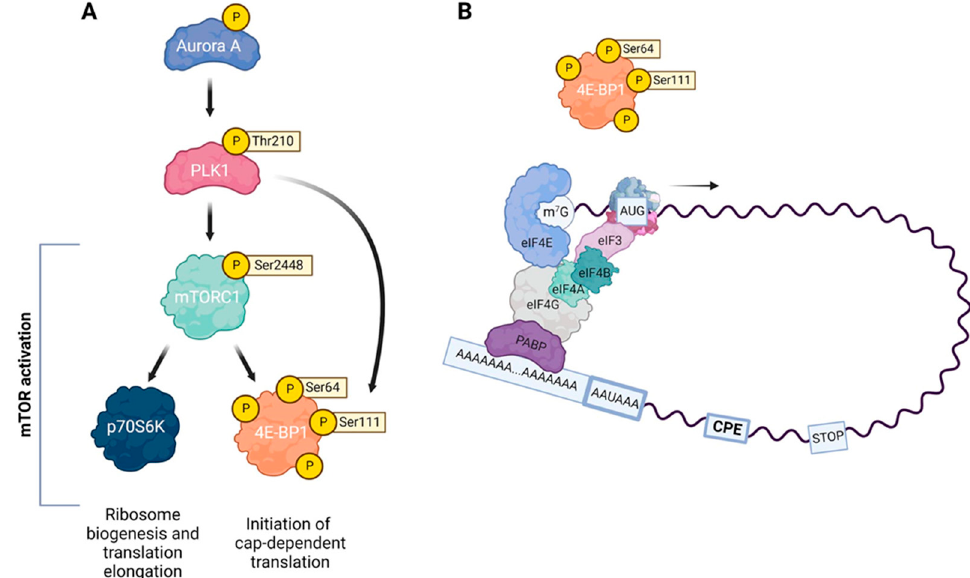
Figure 3. Role of PLK1 in the initiation of translation. ( A ) Activation of polo-like kinase 1 (PLK1) requires phosphorylation of conserved threonine residue (Thr 210) by aurora kinase A (AURKA). Later PLK1 phosphorylates the mammalian target of rapamycin complex 1 (mTORC1), which plays a major role in the phosphorylation and inactivation of eukaryotic translation initiation factor 4E (eIF4E)-binding protein 1 (4E-BP1) and in the initiation of cap-dependent translation. Moreover, PLK1 also regulates the phosphorylation of the 4E-BP1 at the Ser111 residue located on the spindle, enabling the local translation of spindle-associated proteins. Phosphorylated mTORC1 activates p70S6 kinase (p70S6K), resulting in ribosome biogenesis and translation elongation. ( B ) Scheme of cap-dependent translational initiation after poly(A) elongation. MTORC1 hyperphosphorylates 4E-BP1, which results in the dissociation of 4E-BP1 from the cap-binding subunit eIF4E. Released eIF4E together with the RNA helicase eIF4A and large adaptor protein eIF4G form the eIF4F complex, which binds to the m7G cap of mRNA. Poly(A)-binding protein (PABP) binds to the elongated poly(A) tail and eIF4G, forming an mRNA loop and stabilizing the cap. EIF4B interacts with and promotes eIF4A activity and interacts with the eIF3A subunit of the 43S preinitiation complex. After 5 ′ UTR scanning and AUG recognition, the complex recruits a 60S ribosomal subunit and starts protein synthesis.